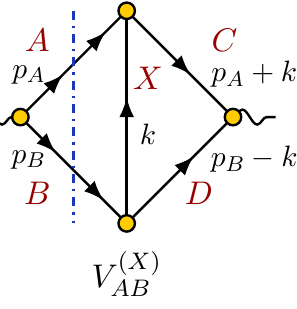
Figure 5 . Diagrammatic comparison between a one-loop two-body decay graph (on the left-side, when the dot-dashed blue cut encounters two particle lines) and a three-body decay process (on the right-side, when the dot-dashed blue cut encounters three particle lines). The indices X , A , B , C , D label the particle in the corresponding leg. The flow of momenta p A , p B and k follows the black arrows. The virtual diagram V ( X ) is related to the Z 0 → AB decay with particles X , C and AB is related to the D entering as internal particles in the one-loop correction. The real diagram R ( X ) AD three-body decay Z 0 → ADX with particles C and B entering as internal